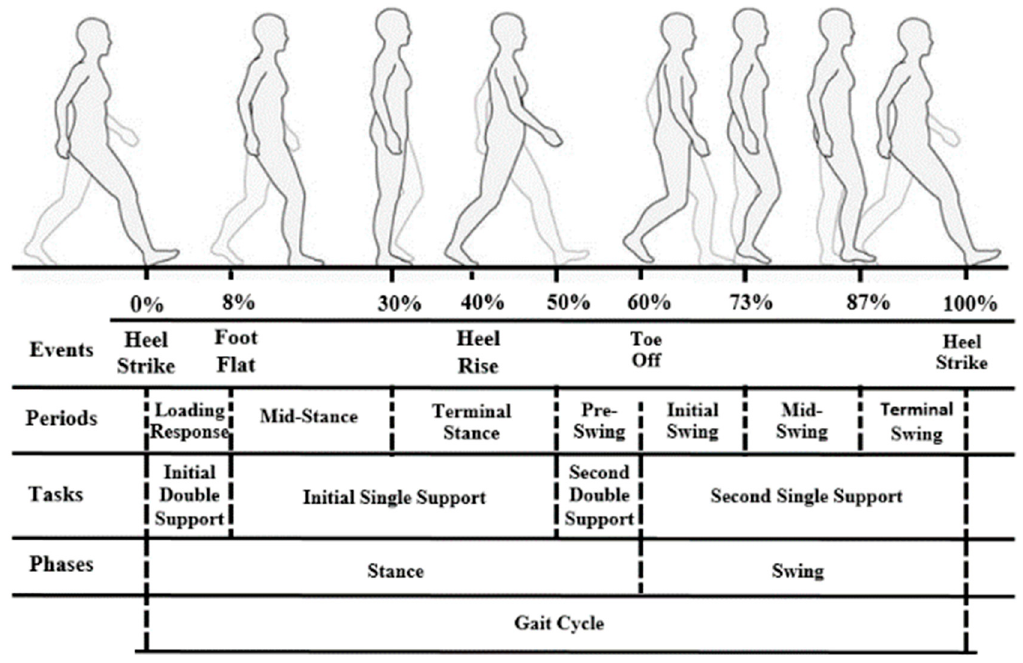
Figure 1. The gait cycle: events, periods, tasks, and phases. (Figure designed based on [6,11–13]).